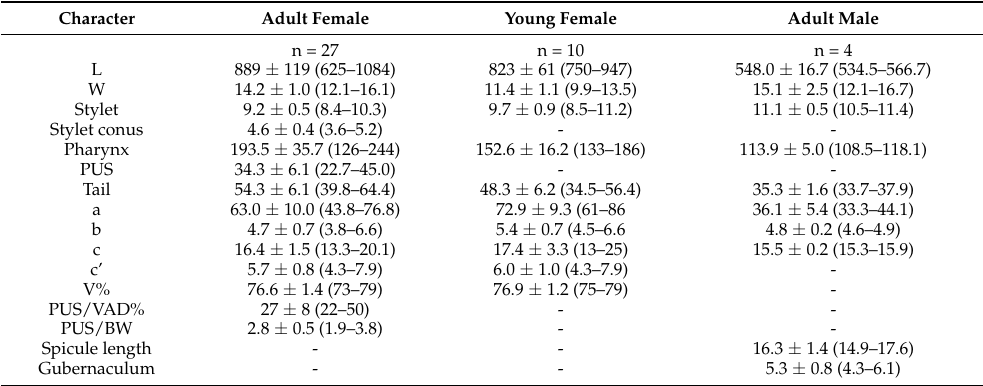
Table 6. Morphometrics of Litylenchus crenatae mccannii ssp. from Perry, OH. All measurements are given in µ m (after Carta et al. [19]).